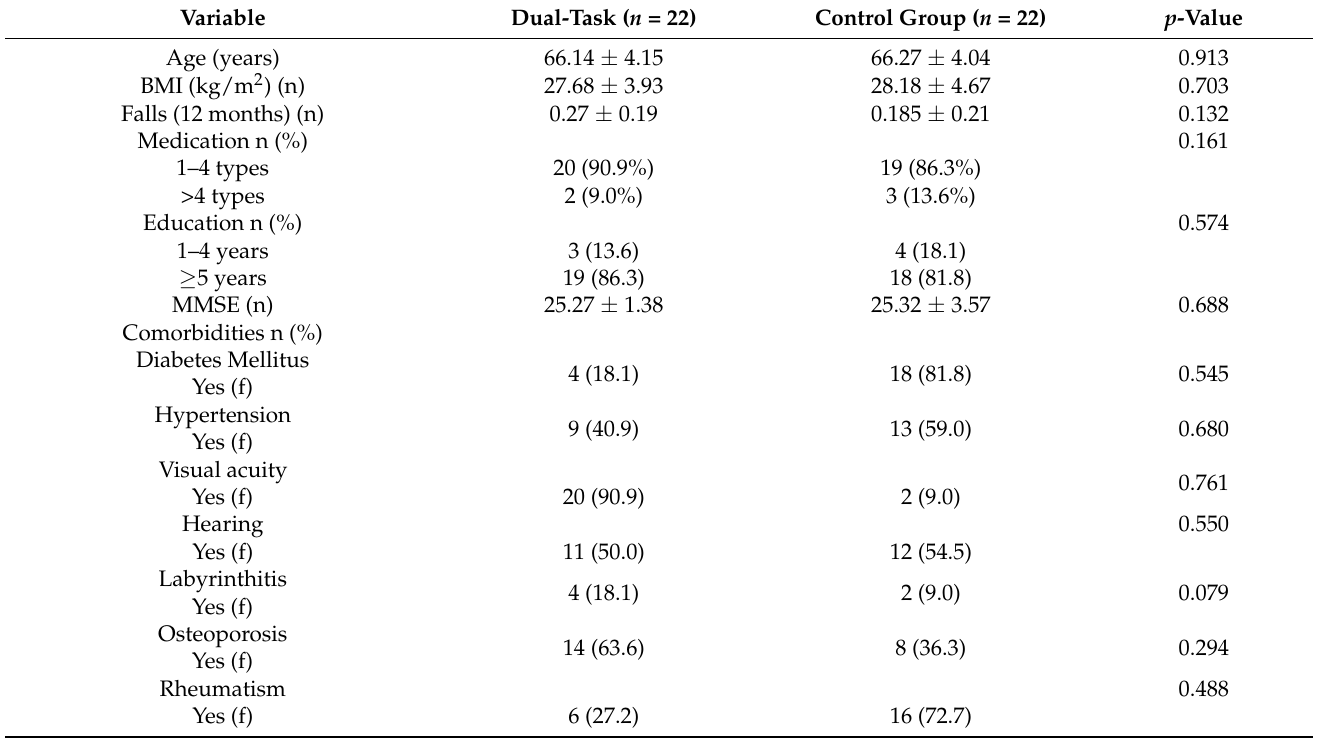
Table 3. Main characteristics of participants in the